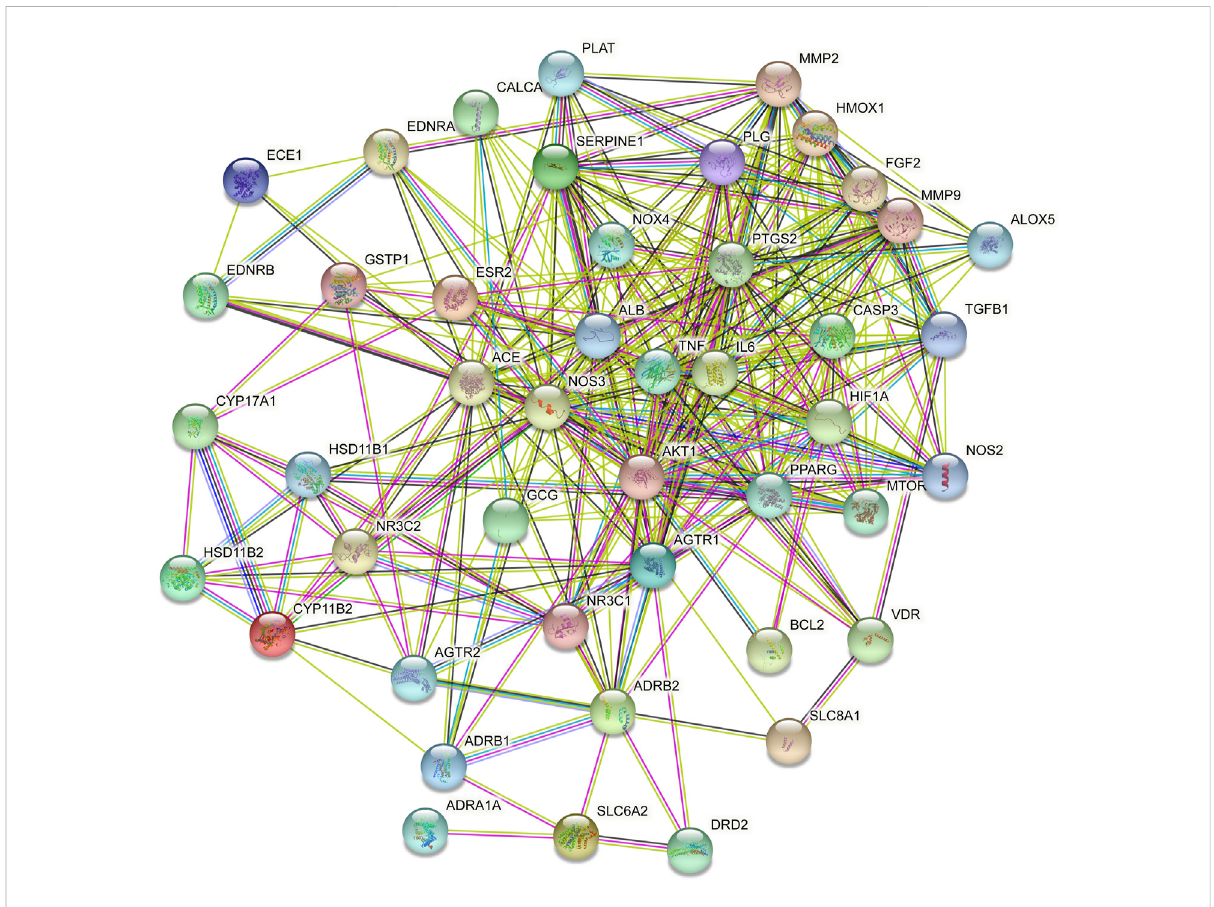
FIGURE 11 PPI of the key